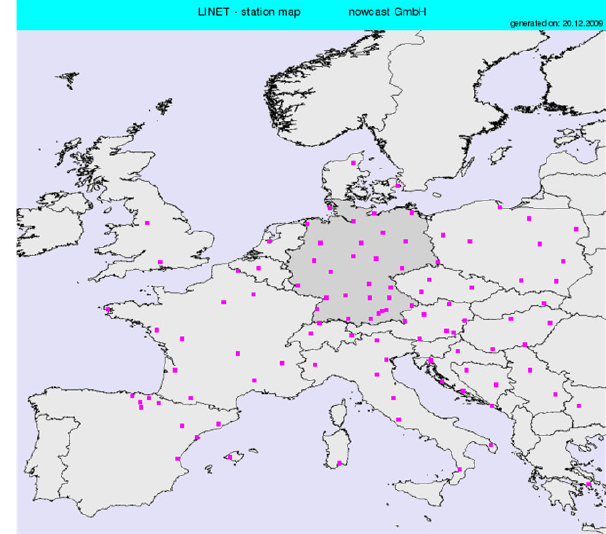
Figure 4 1 Fig. 4. Distribution of LINET sensors in Europe as of Decem- ber